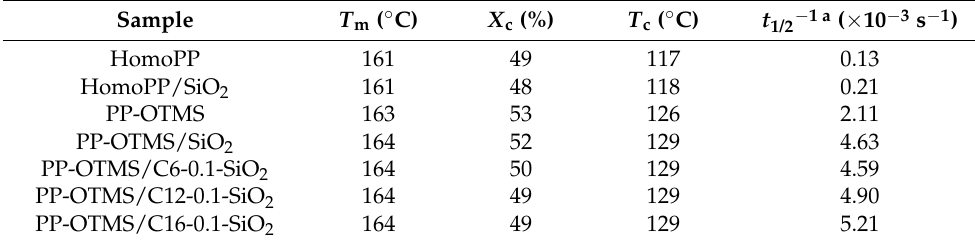
Table 2. Melting and crystallization behaviors of nanocomposites analyzed by